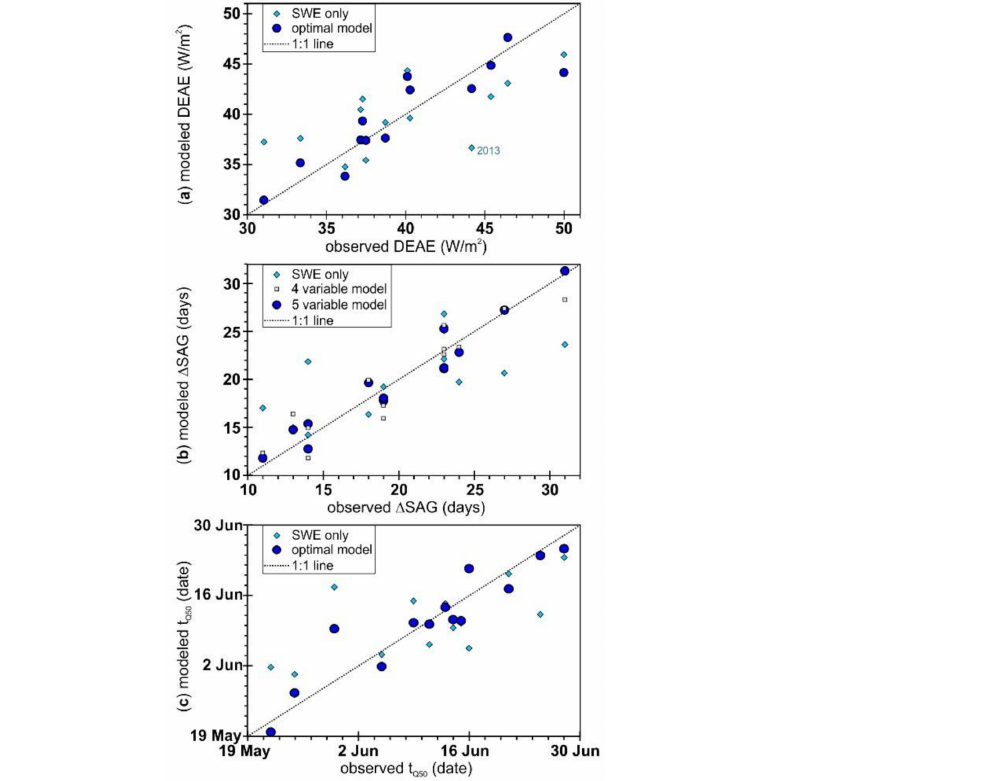
Figure A3. Modeled vs. observed ( a ) DEAE, ( b ) ∆ SAG, and ( c ) t Q50 for SWE only and the optimal multi-variate linear regression models (see Table